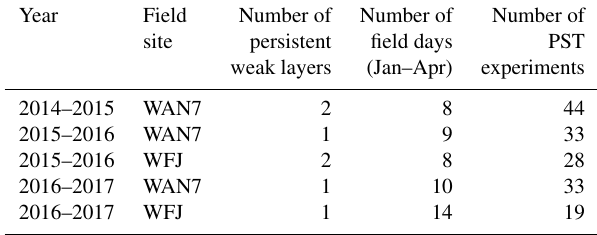
Table 1. Overview of number of weak layers and propagation saw test (PST) results available for validation; data collected during three winter seasons and at two field sites: Weissfluhjoch (WFJ) and Wannengrat